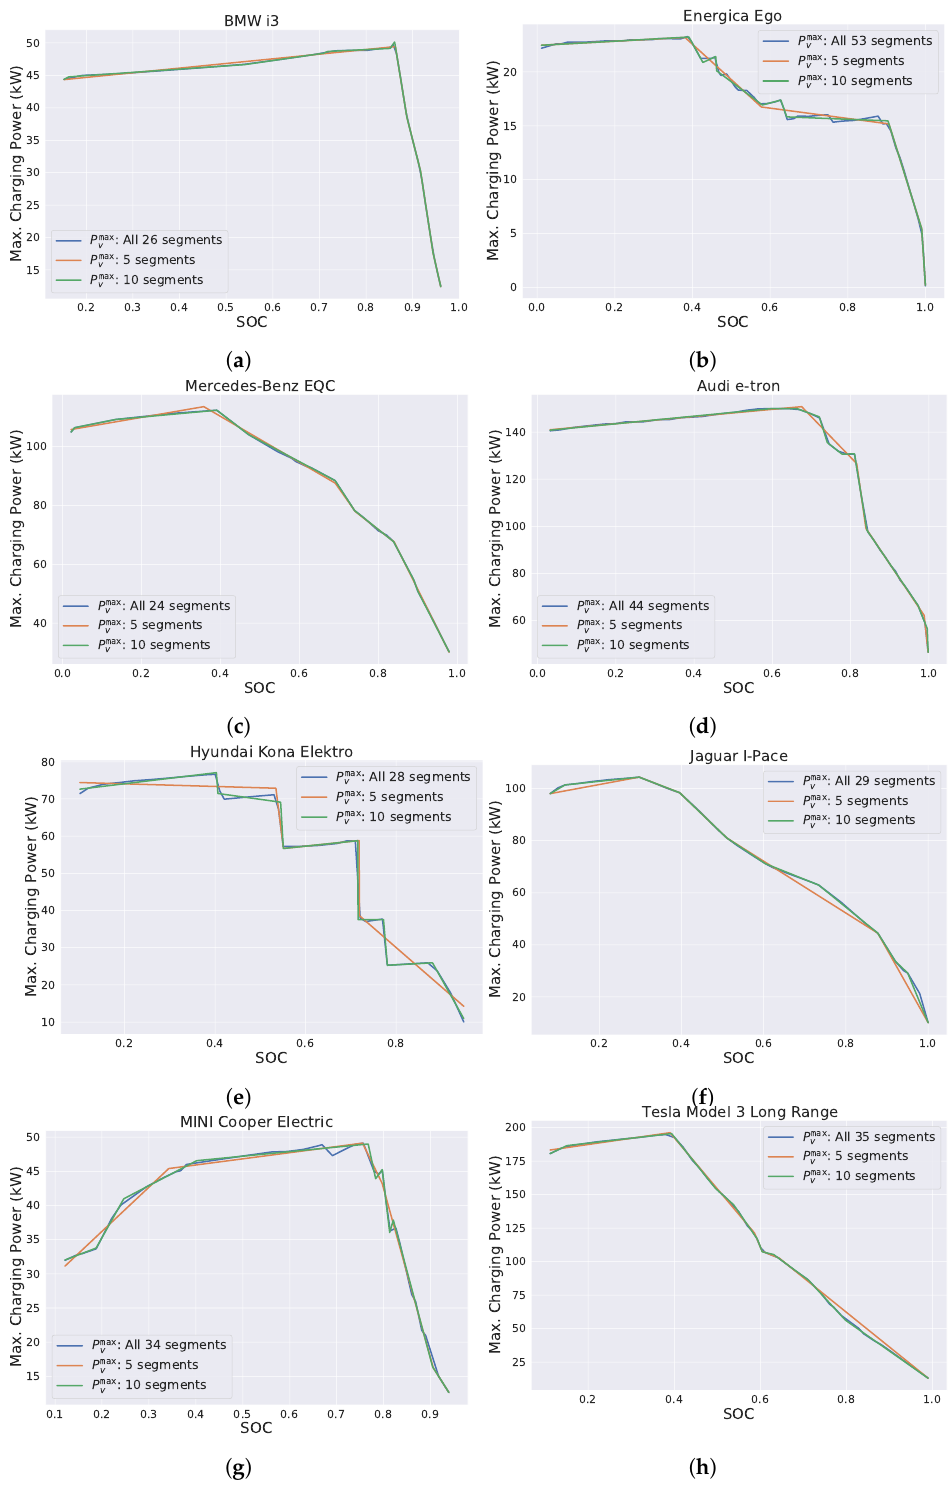
Figure A1. Comparison of P max v curves with different numbers of segments. ( a ) P max v curves for BMW i3. ( b ) P max v curves for Energica Ego. ( c ) P max v curves for Mercedes-Benz EQC. ( d ) P max v curves for Audi e-tron. ( e ) P max v curves for Hyundai Kona Elektro. ( f ) P max v curves for Jaguar I-Pace. ( g ) P max v curves for MINI Cooper Electric. ( h ) P max v curves for Tesla Model 3 Long